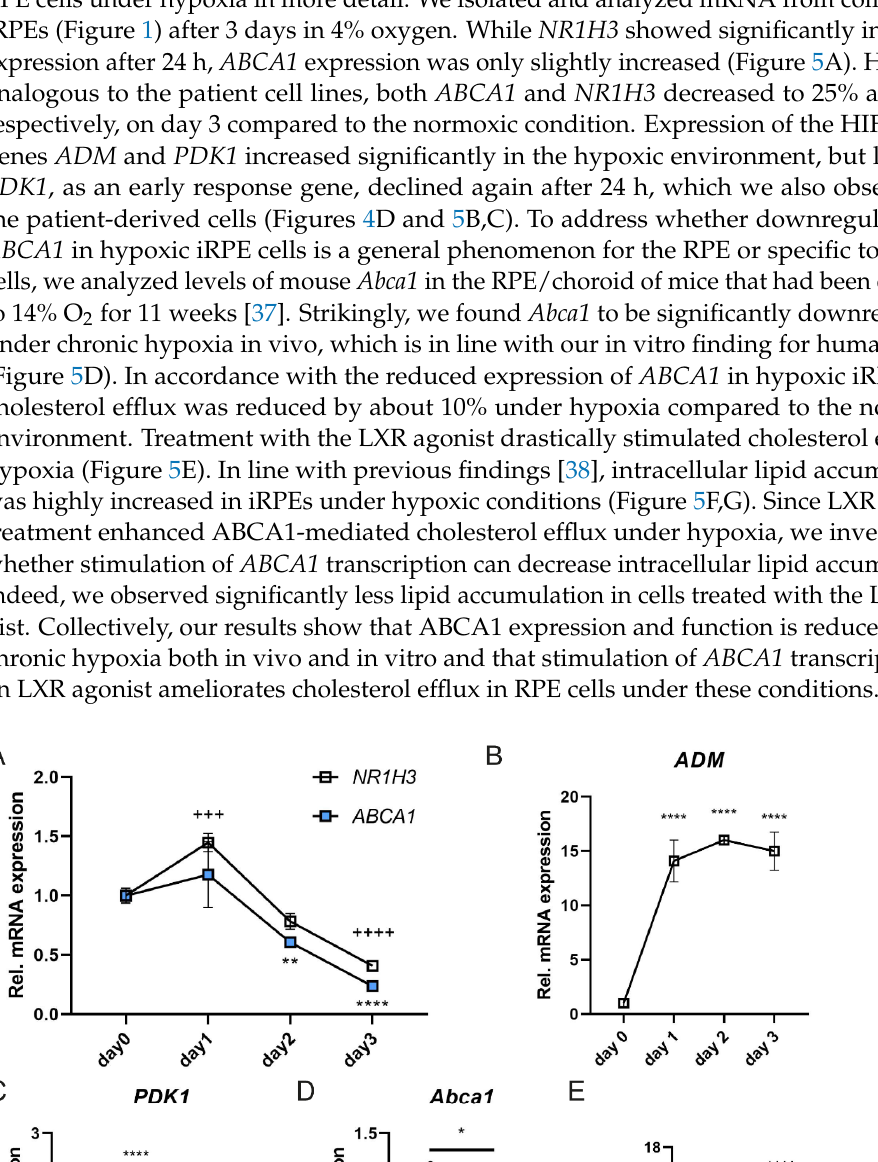
Figure 5. ABCA1 expression and function under hypoxia in iRPEs. ( A – C ) Relative expression of ( A ) ABCA1 and NR1H3 , ( B ) ADM and ( C ) PDK1 mRNA in iRPEs before and after 1, 2 and 3 days incu- bation at 4% O 2 (hypoxia). All data were normalized to RPL28 and are presented as means ± SD (n = 3). One-way ANOVA with Tukey’s post hoc test to day 0. * p < 0.05; ** p < 0.01; +++ p < 0.001; ****/ ++++